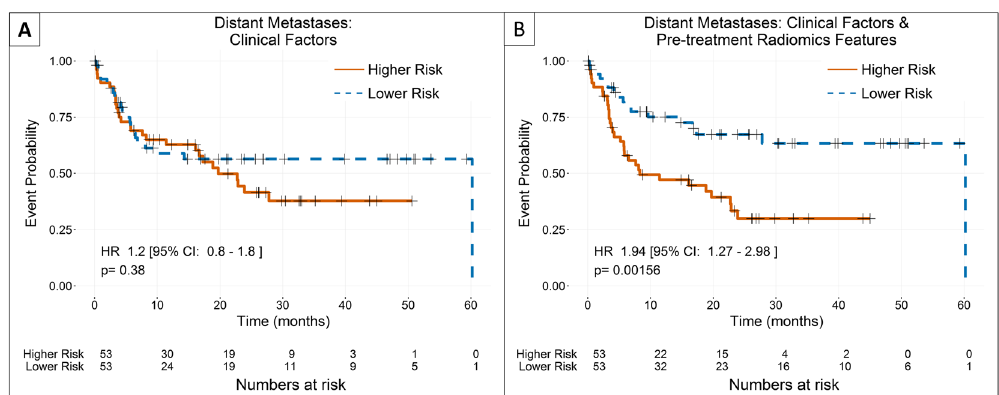
Figure 4. Comparison of Kaplan-Meier curves for distant metastases using the two nested models with patients stratified by the median predicted value of each model. No delta-radiomics features were selected in the model- building process for distant metastases, so only two models were available. For distant metastases, the addition of a pretreatment radiomics feature, compactness2, significantly improved the stratification of the